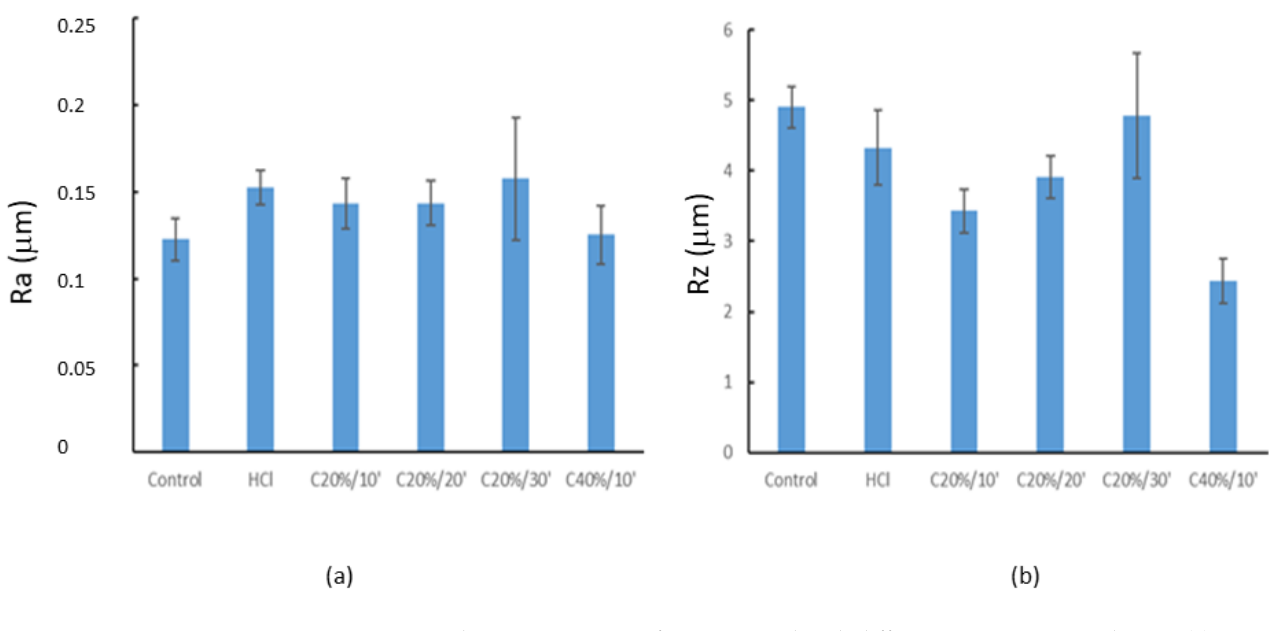
Figure 3. Roughness parameters of cp. Ti treated with different passivation conditions; ( a ) Ra, and ( b ) Rz.